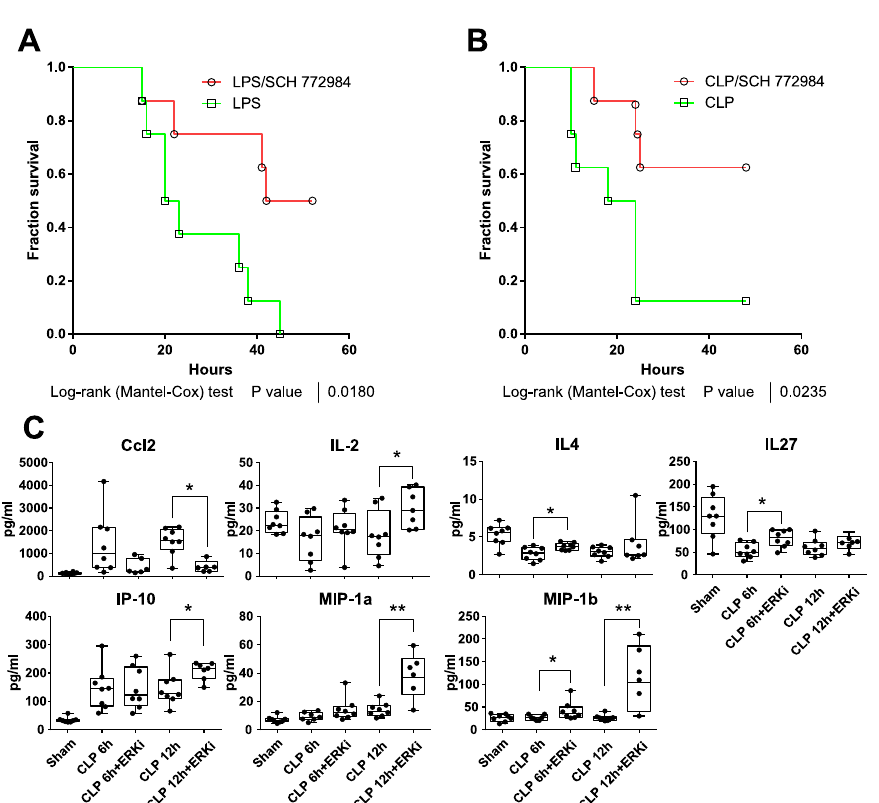
Figure 3. SCH772984 improves survival in mouse models of sepsis and reduces plasma levels of Ccl2/Mcp1 chemokine. Kaplan–Meier survival curves of ( A ) LPS-treated C57BL/6W mice (20 mg/kg, i.p., n = 8 per group) or mice subjected to cecal ligation puncture (CLP) procedure ( B ) that were both injected i.p. with solvent control or 10 mg/kg of SCH772984 2 h after LPS administration/CLP procedure. ( C ) Plasma levels of indicated cytokines were measured with the 26-Plex Mouse ProcartaPlex immunoassay in CLP, SCH772984 (ERKi)-treated CLP, and sham-operated animals ( n ≥ 6) at 6 and 12 h endpoint. ** p < 0.01, * p < 0.05 as determined by unpaired T ‐ test. Only seven cytokines with significant alternations in plasma levels following SCH772984 are shown.